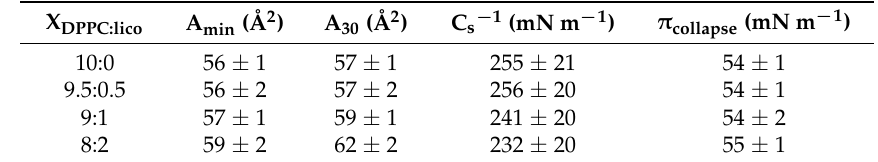
Table 1. Minimum area per lipid molecule (A min ), area per lipid molecule at 30 mN m − 1 (A 30